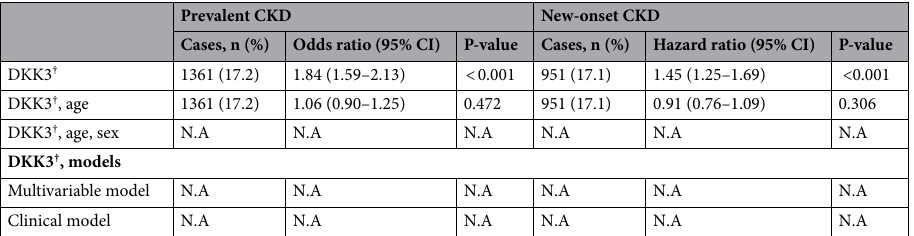
Table 5. DKK3: Prevalent and new-onset CKD. CI Confidence Interval, CKD Chronic kidney disease, DKK3 Dickkopf-3. Multivariable model as presented in Table 3. Clinical model includes age, sex, body mass index, systolic blood pressure, glucose † and cholesterol. Prevalent CKD: N = 7946. New onset CKD: N = 5548. † Log2-